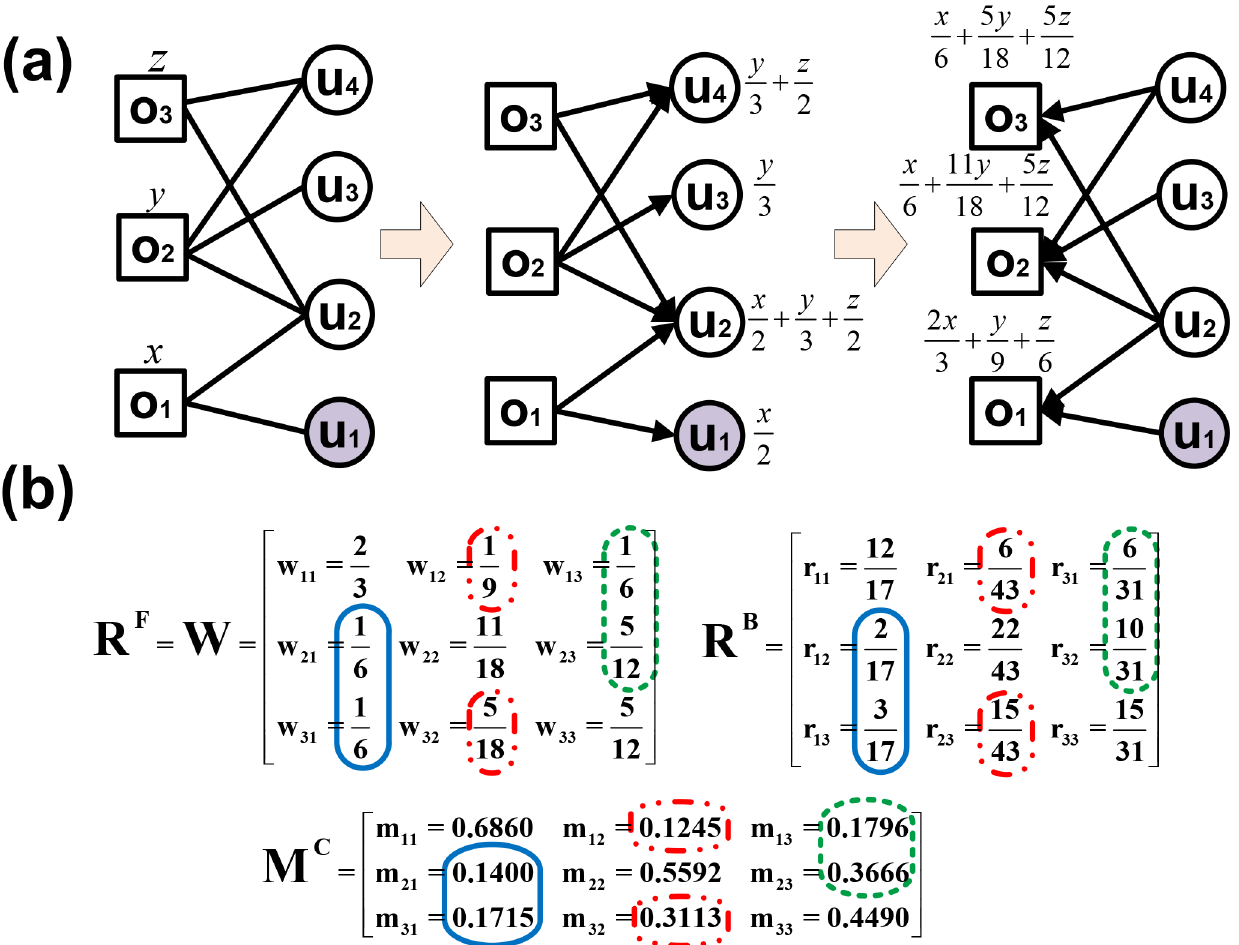
Fig 1. Illustrating the apparent similarity problem. (a) the description of a unweighted undirectedobject-user bipartite network, with objects denotedby squaresand users by round circles. (b) Matrices W , R F , R B and M C indicate similarity matrix of NBI, forward and backward similarity proportionmatrices and corrected similarity matrix, respectively. Color circles highlightthe corresponding relationsof similarity elementsin different similarity matrices. Here element m ij in M C equals to